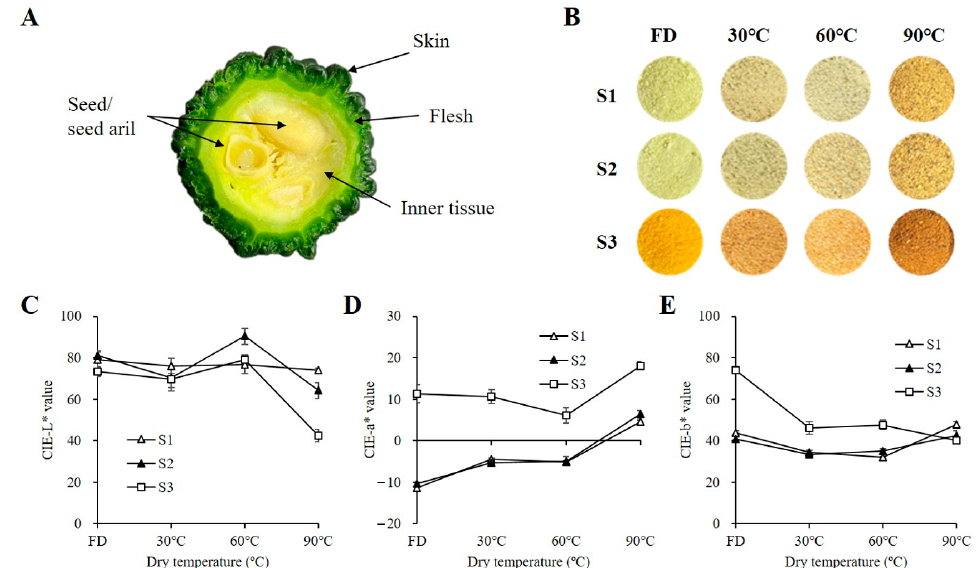
Figure 1. Morphological characteristics of M. charantia ( A ) cross section at the central part of M. charantia , ( B ) visual color, and ( C ) their CIE L*, ( D ) a*, and ( E ) b* values of M. charantia (ground powder) at different stages after thermal processing for 3 days. FD indicates freeze dry. S1, S2, and S3 indicate immature green fruit about 15 days after fertilization (DAF), mature green fruit about 25 DAF, and mature yellow fruit about 30 DAF.